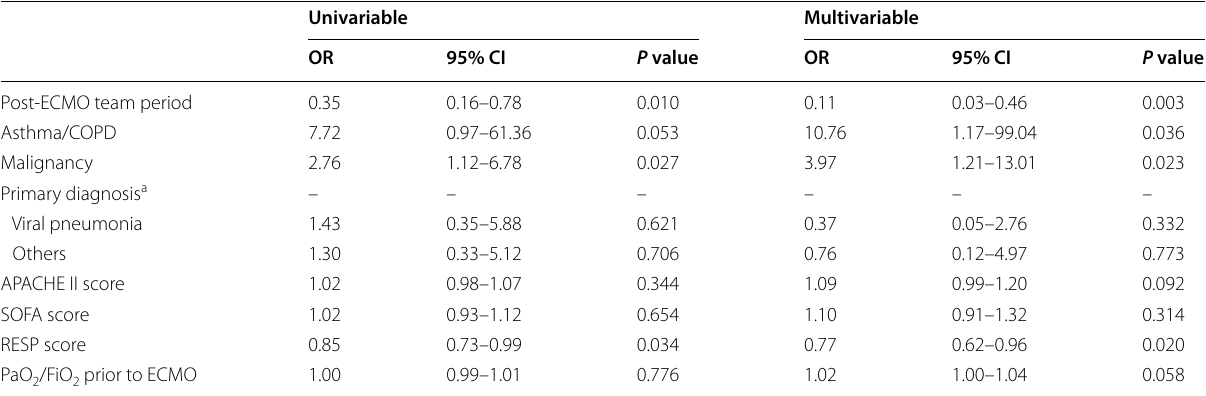
APACHE II acute physiology and chronic health evaluation II, COPD chronic obstructive pulmonary disease, ECMO extracorporeal membrane oxygenation, FiO 2 fraction of inspired oxygen, MV mechanical ventilation, PaO 2 partial pressure of oxygen in arterial blood, RESP respiratory extracorporeal membrane oxygenation survival prediction, SOFA sequential organ failure assessment a The reference group is bacterial